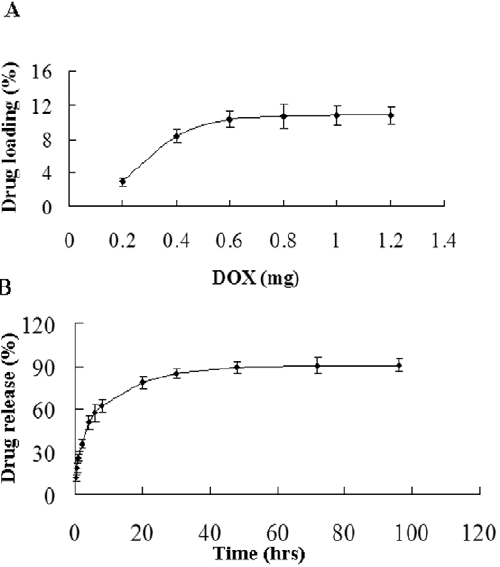
Figure 1. Efficiency of DOX loading onto the surface of PGMNPs and the behavior of DOX release from DOX-PGMNPs conjugates. ( A ) Efficiency of DOX loading onto the surface of PGMNPs was analyzed by HPLC. The amount of DOX conjugated to PGMNPs was positively correlated with the DOX mass added. ( B ) DOX release from DOX-PGMNPs conjugates was analyzed by HPLC. The slow, steady, and controlled release of DOX was observed.